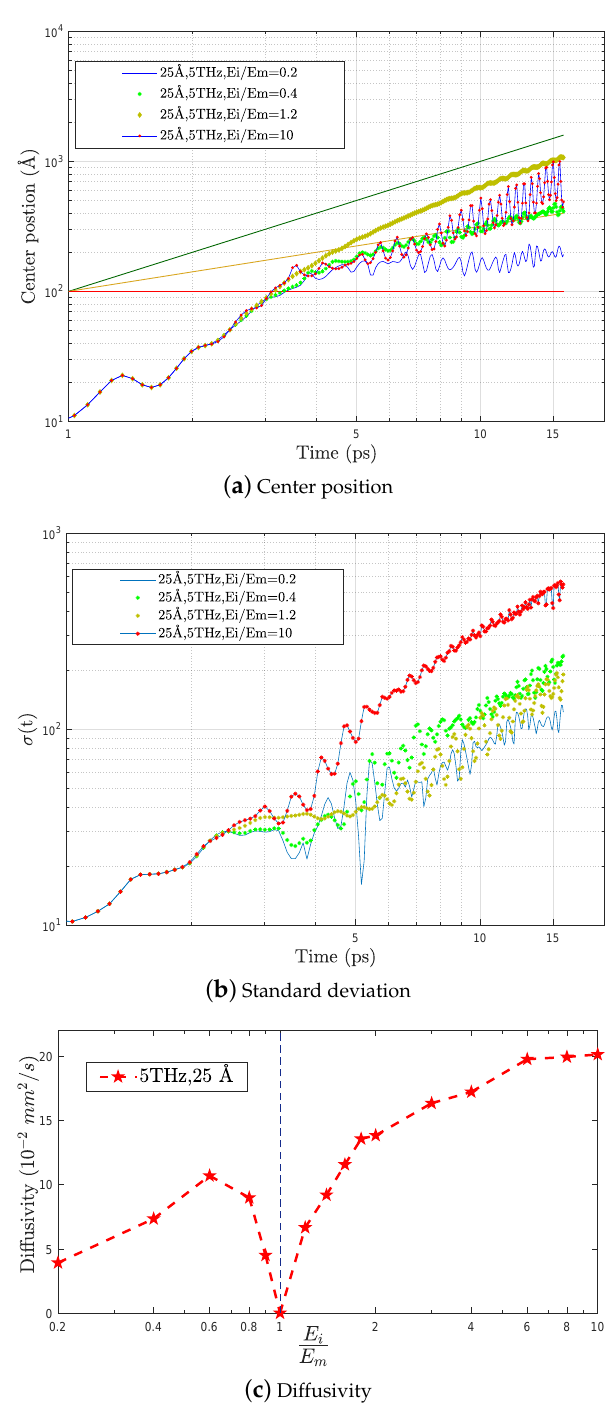
Figure 9. ( a ) Time dependence of the wave packet center position for different rigidity contrasts. We report as well the expected behaviors for propagative regime (cid:104) x (cid:105) ( t ) ∝ Vt (green line), diffusive regime (cid:104) x (cid:105) ( t ) ∝ ( 2 Dt ) 1 2 (yellow line) and localized regime (cid:104) x (cid:105) ( t ) ∝ cst (red line). ( b ) Standard deviation versus time calculated by Equation (6). ( c ) Diffusivity obtained from Equation (9) using an excitation with random polarizations, for different values of the rigidity contrast E i / E m